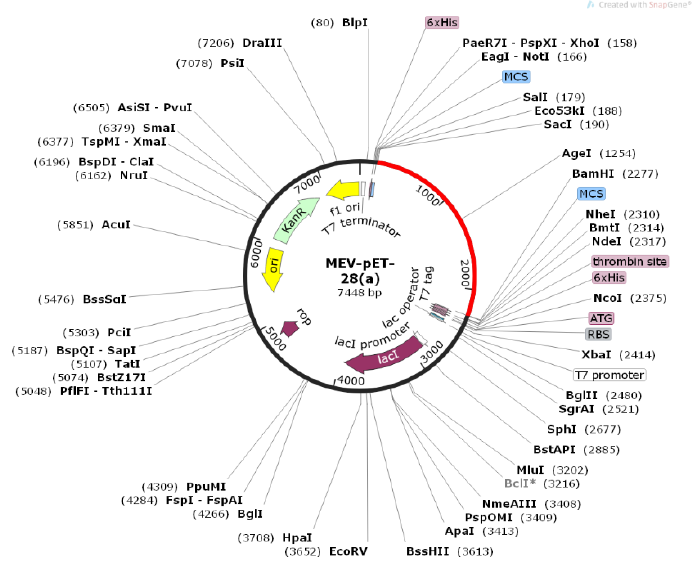
Figure 6. In silico cloning of the MEV construct into pET-28a (+) vector. The insert is shown in red.